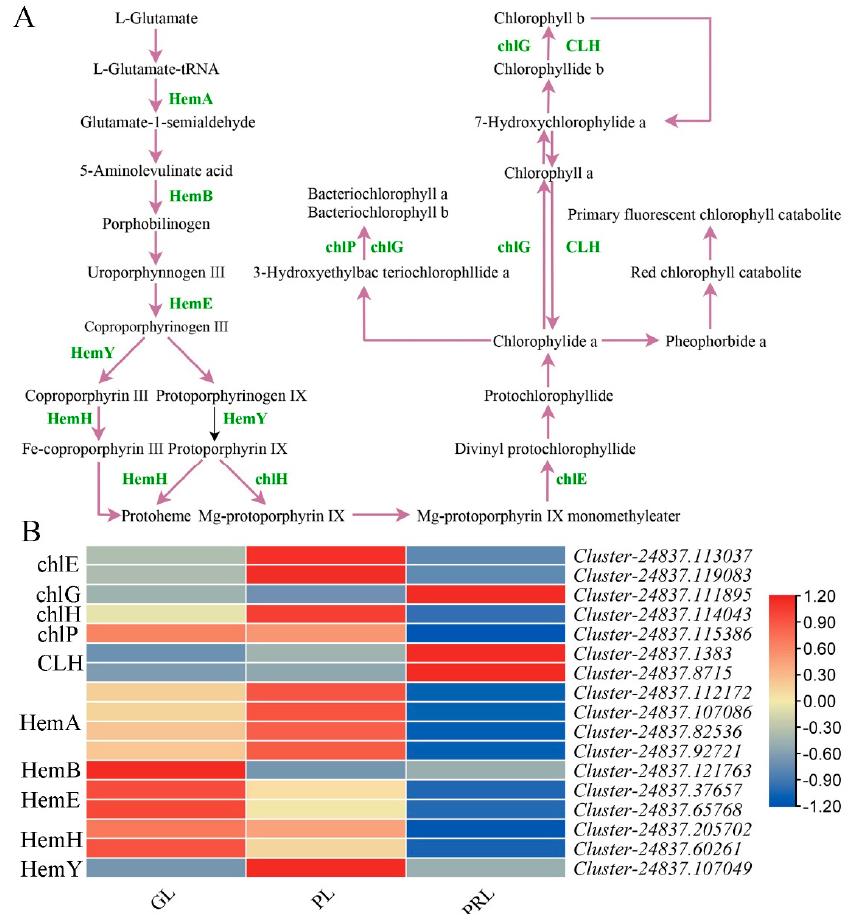
Figure 7. Biosynthetic pathway of chlorophyll in P. virginiana leaf color change. ( A ) Reconstruction of the chlorophyll biosynthetic pathway with the differentially expressed structural genes ( B ). Heatmap of the differentially expressed genes (DEGs) involved in chlorophyll biosynthetic pathway. Gene expression was scaled using Z-scores of fragments per kilobase of exon per million fragments mapped (FPKM) for mean valued of three biological replicates in heatmaps. The cluster marker on the right side of heatmap represents the names of each gene. GL, green leaf; PL, purple leaf; PRL, purple-red leaf; HemA, glutamyl-tRNA reductase; HemB, prophobilinogen synthase; HemE, uroporphyrinogen decarboxylase; HemY, copropophyrinogen III oxidase; HemH, ferrochelatase; chlH, magnesium chelatase subunit H; chlE, anaerobic magnesium-protoporphyrin IX monomethyl ester cyclase; chlG, chlorophyll a synthase; chlP, geranylgeranyl reductase; CLH,